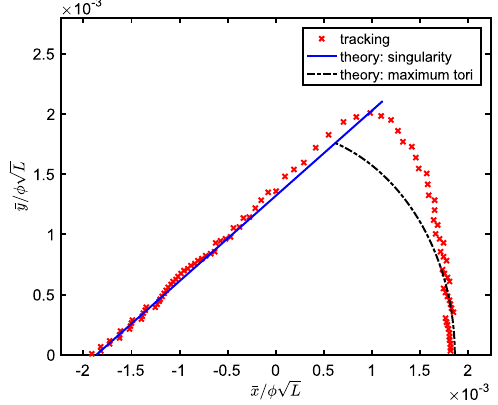
13. A set of invariant tori in the normalized 4D phase spaces near the sum resonance: ν red dots represent the periodic orbits from tracking with bend length L ¼ 5 m and angle ϕ ¼ π = 64 , the blue lines are the special solutions of the Hamiltonian in Eq. (23) with Δ ν ¼ 0 . 01 and θ ¼ − 76 . 73 m − 1 = 2 , the black lines are the maximal tori predicted by the